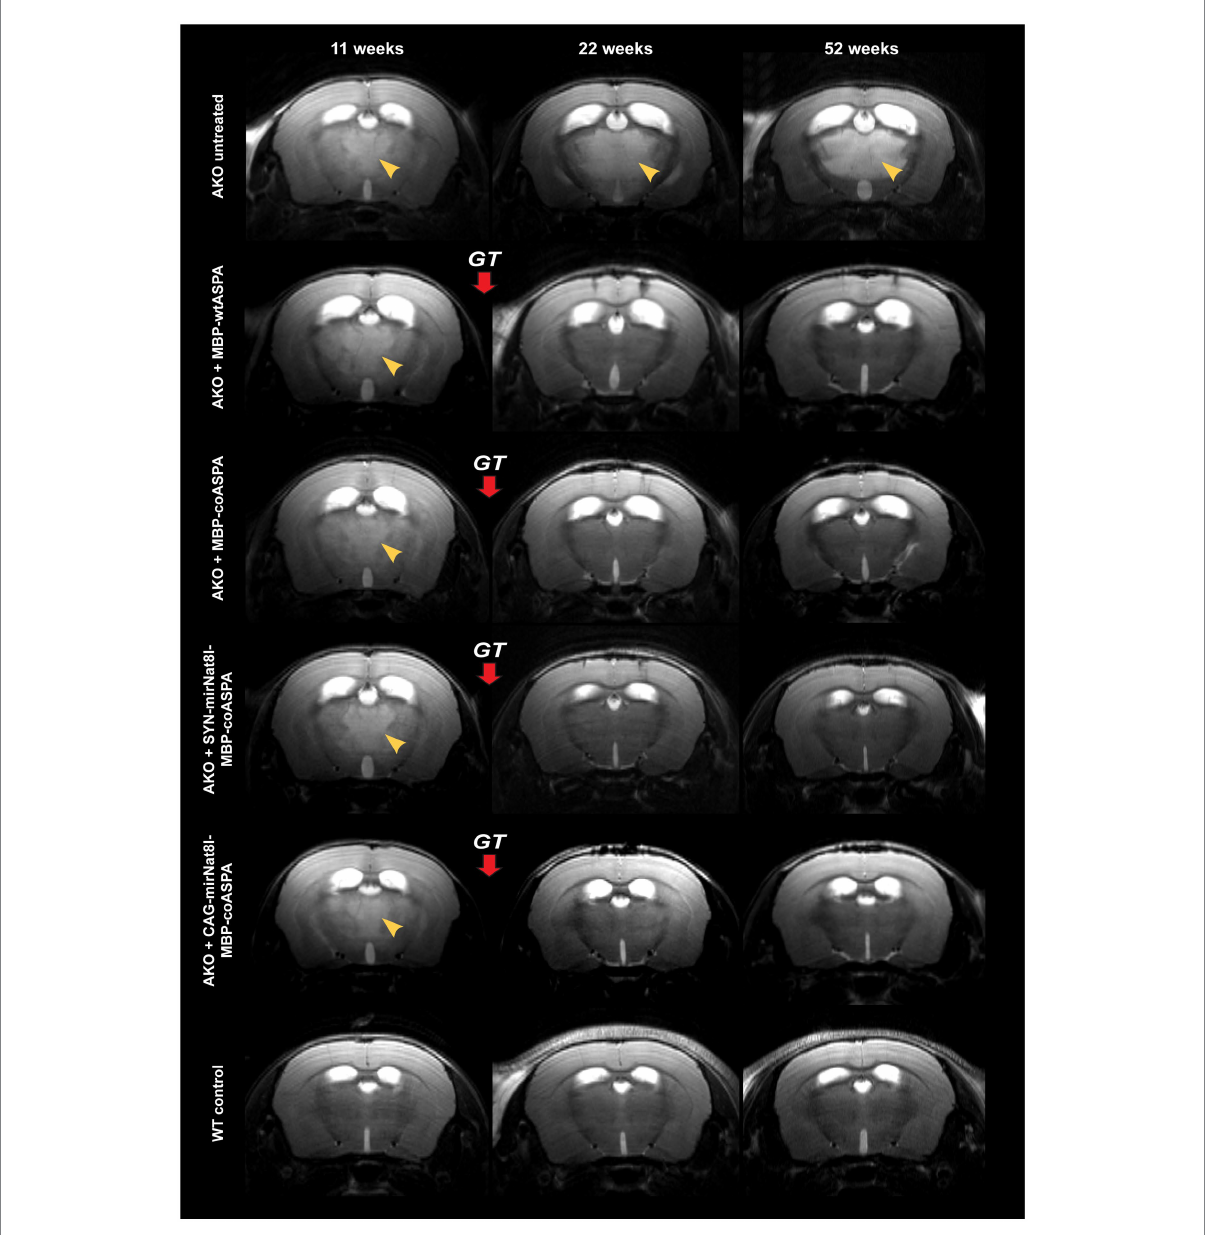
FIGURE 6 Treatment with novel gene therapy vectors reverses brain vacuolization and ventricle dilation in aged AKO mice. AAV vectors were injected bilaterally into striatum, thalamus, and cerebellum (3 × 10 9 vg per site) of 12-week-old AKO mice. The same mice were imaged before as well as 10-and 40-weeks post gene therapy (GT). Representative T2-weighted brain MRI images are displayed. Yellow arrowheads indicate T2 hyperintensities reflecting progressive spongiform